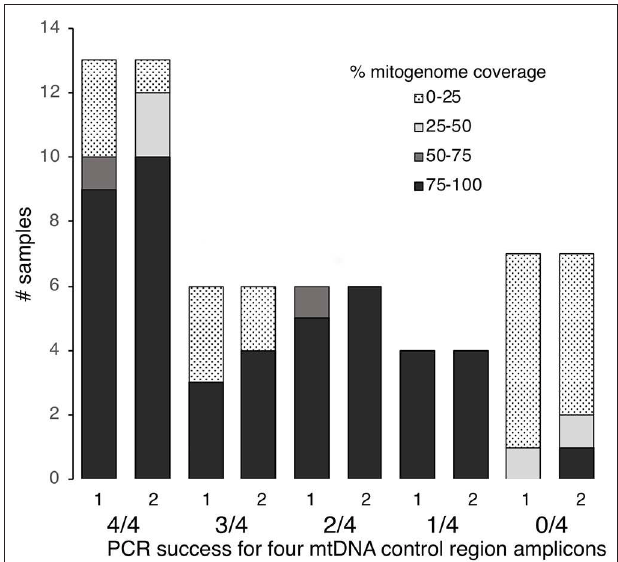
one or two rounds of hybridization enrichment and MPS, compared to control region PCR success (4/4, 3/4, 2/4, 1/4, or 0/4 fragments